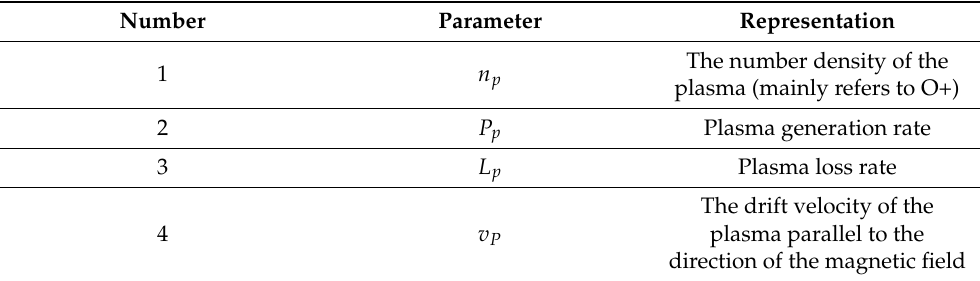
Table 3. The meaning of related parameters in the Formula (8).